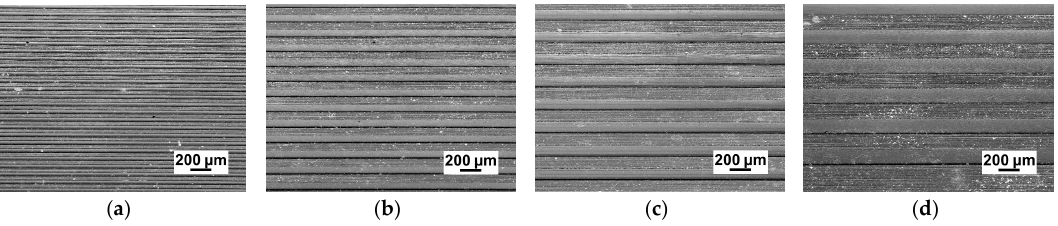
Figure 2. SEM of micro-array channels dies with different widths: ( a ) 50 μ m; ( b ) 100 μ m; ( c ) 150 μ m; ( d ) 200 μ m.